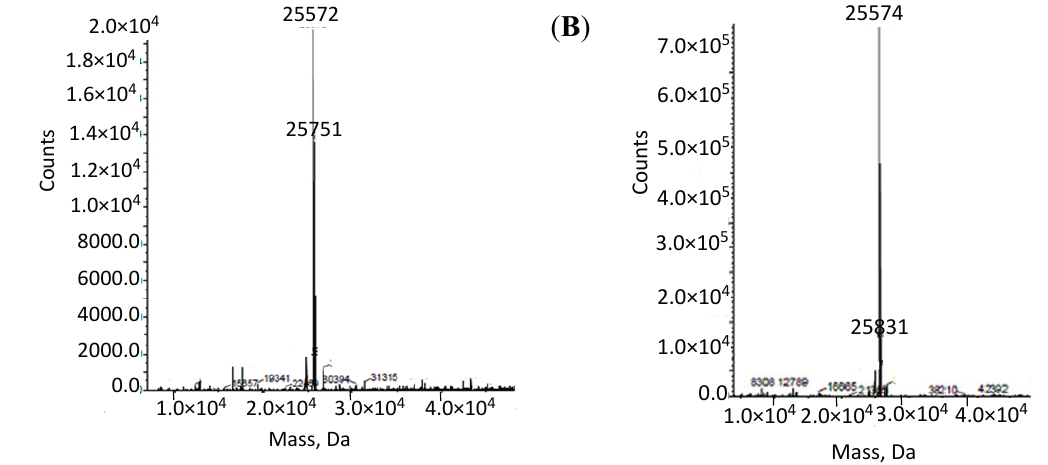
Figure 7. Mass Spectra (positive TOF) ( A ) Prx 4 after reaction with BNP7787, peak at 25572 corresponds to Prx monomer containing two BNP7787-derived mesna adducts (apo-protein is approximately 25292); ( B ) BNP7787-Prx 4 co-crystal protein sample